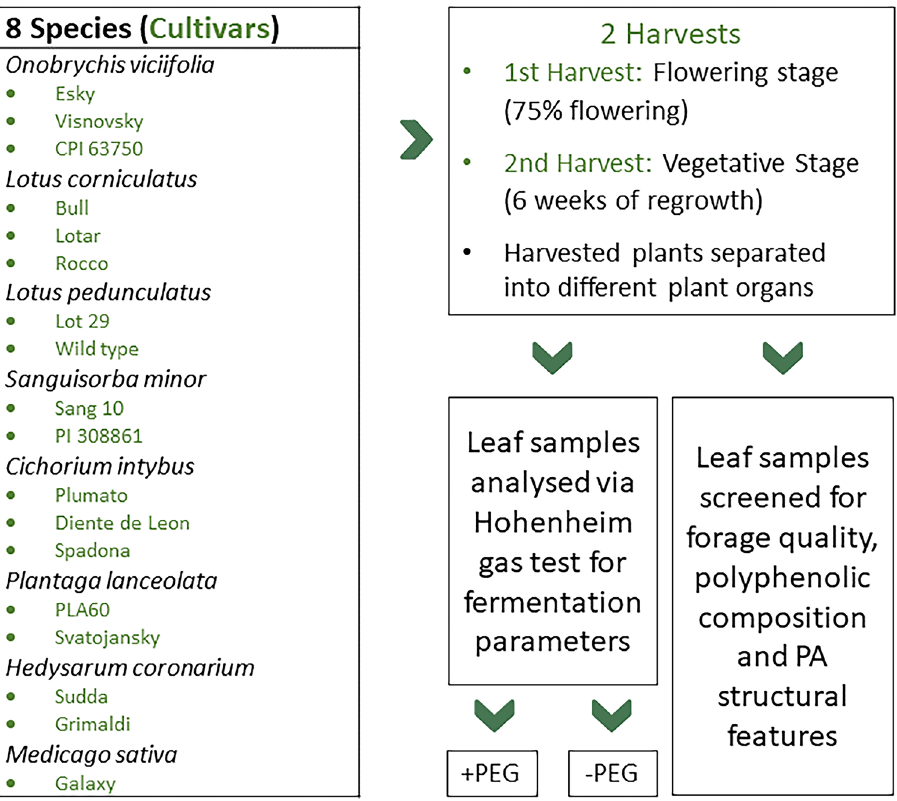
Figure 1. A greenhouse experiment was conducted with 17 cultivars from eight forage species. The cultivars were harvested twice at different phenological stages (Flowering and vegetative stage). Harvested plants were analysed for their polyphenolic composition, PA structural features, and antimethanogenic